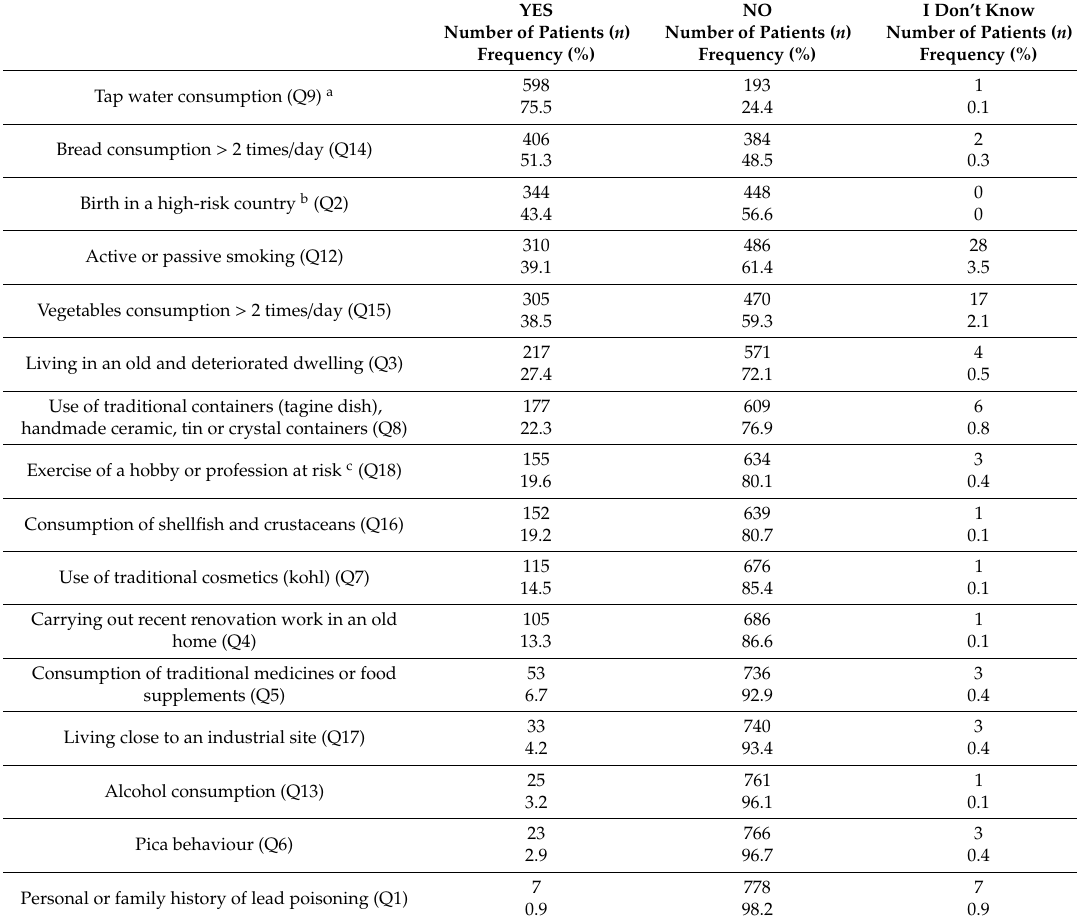
Table 1. Frequency of lead exposure risk factors mentioned in the questionnaire.